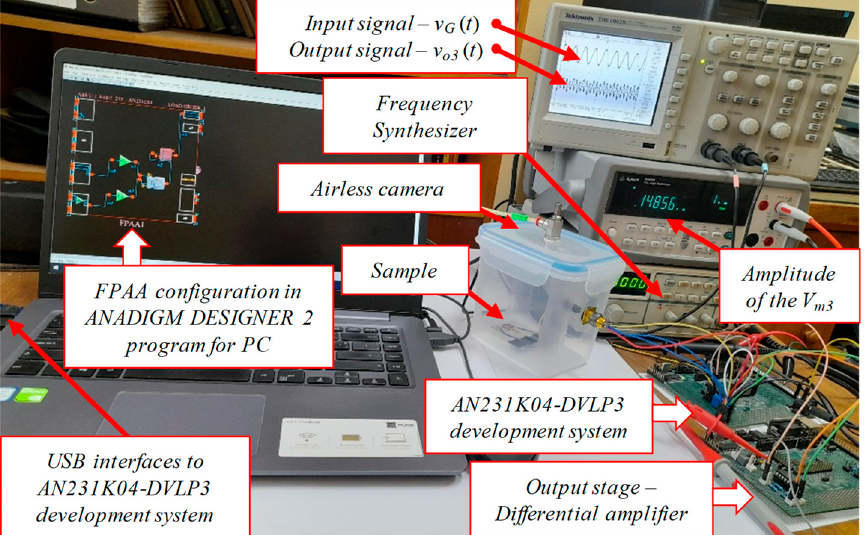
Figure 5. Experimental setup for the prototype of the programmable analog circuit integrated with the novel thin-film structure.